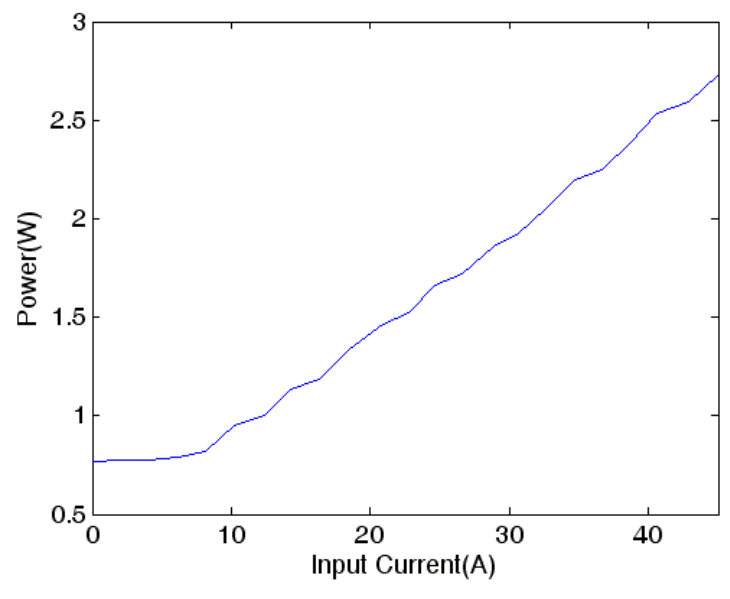
Figure 9. Power consumption vs. the input